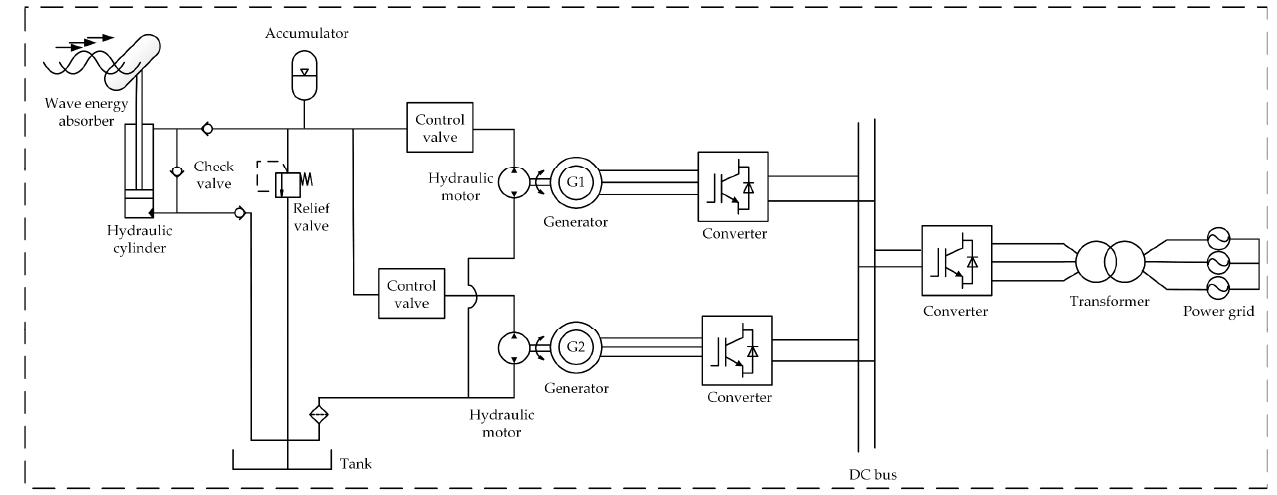
Figure 1. Double ‐ branch hydraulic energy storage wave power ‐ generation system. Figure 1. Double-branch hydraulic energy storage wave power-generation system. Table 1. Comparison of system output power. Table 1. Comparison of system output